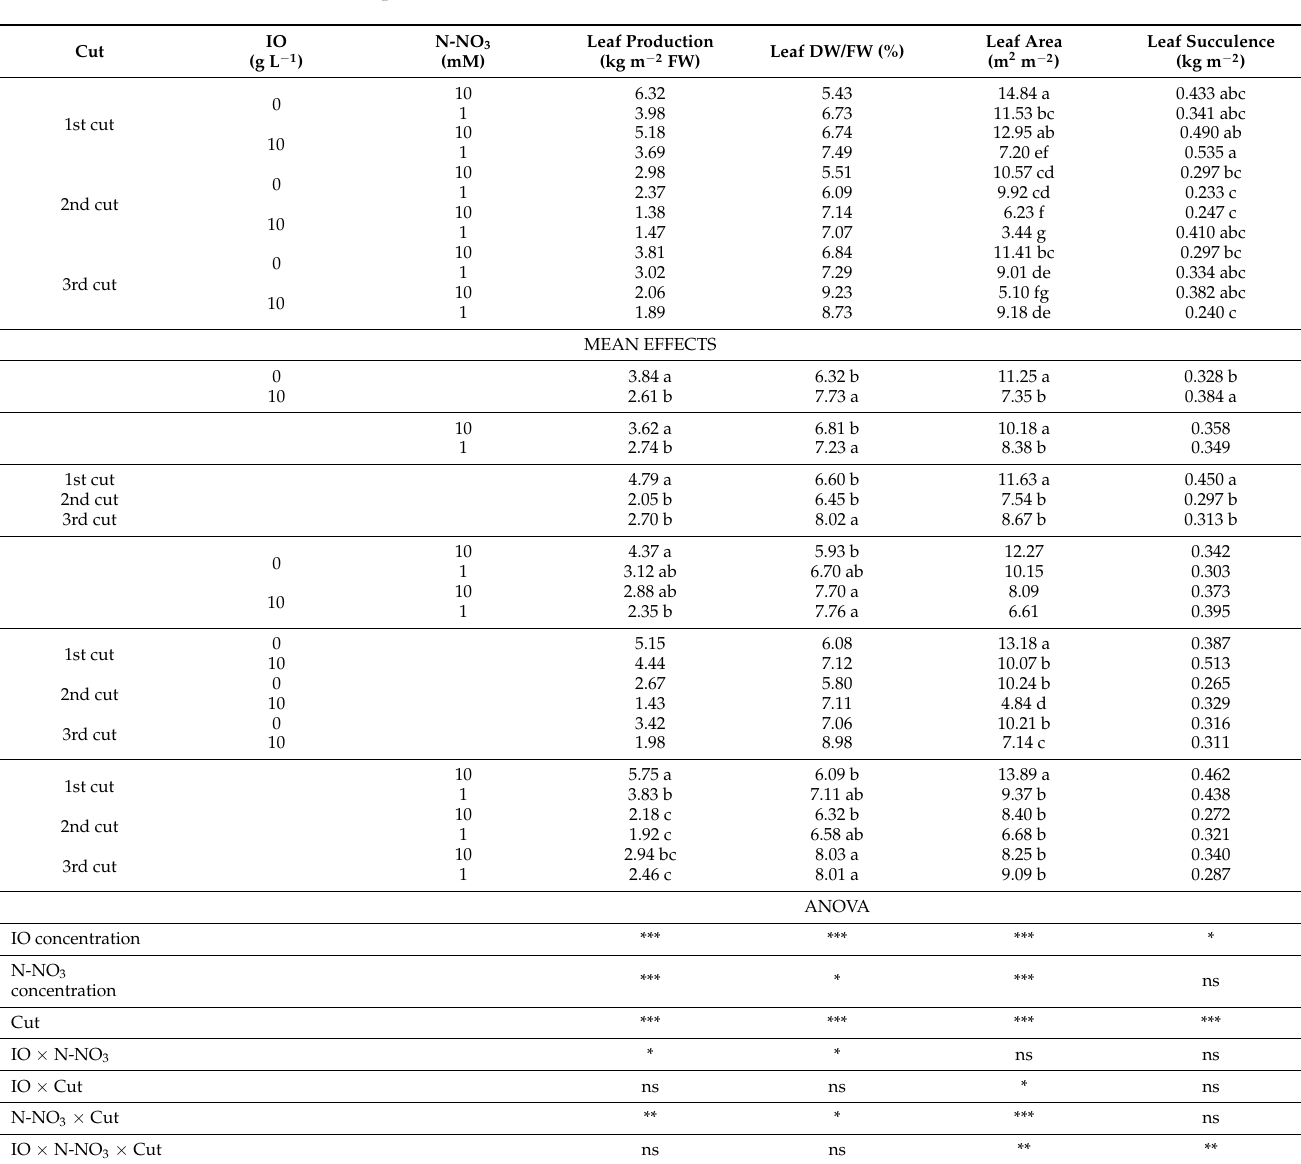
Table 8. Leaf production (fresh weight, FW), dry weight/fresh weight ratio (DW/FW), leaf area and succulence of sea beet plants grown with hydroponically different concentrations of the sea salt Instant Ocean (IO; 0 and 10 g L − 1 ) and nitrogen (1 and 10 N-NO 3 mM) in the nutrient solution. The leaves were harvested trice during the experiment (see Table 1 for more detailed information on the